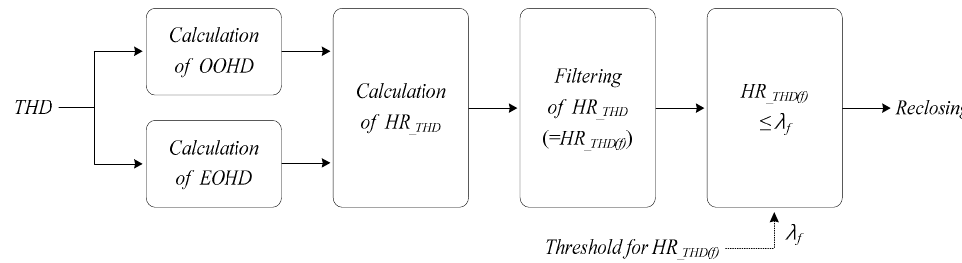
Figure 13. Diagram of the proposed scheme for detection of secondary arc extinction.